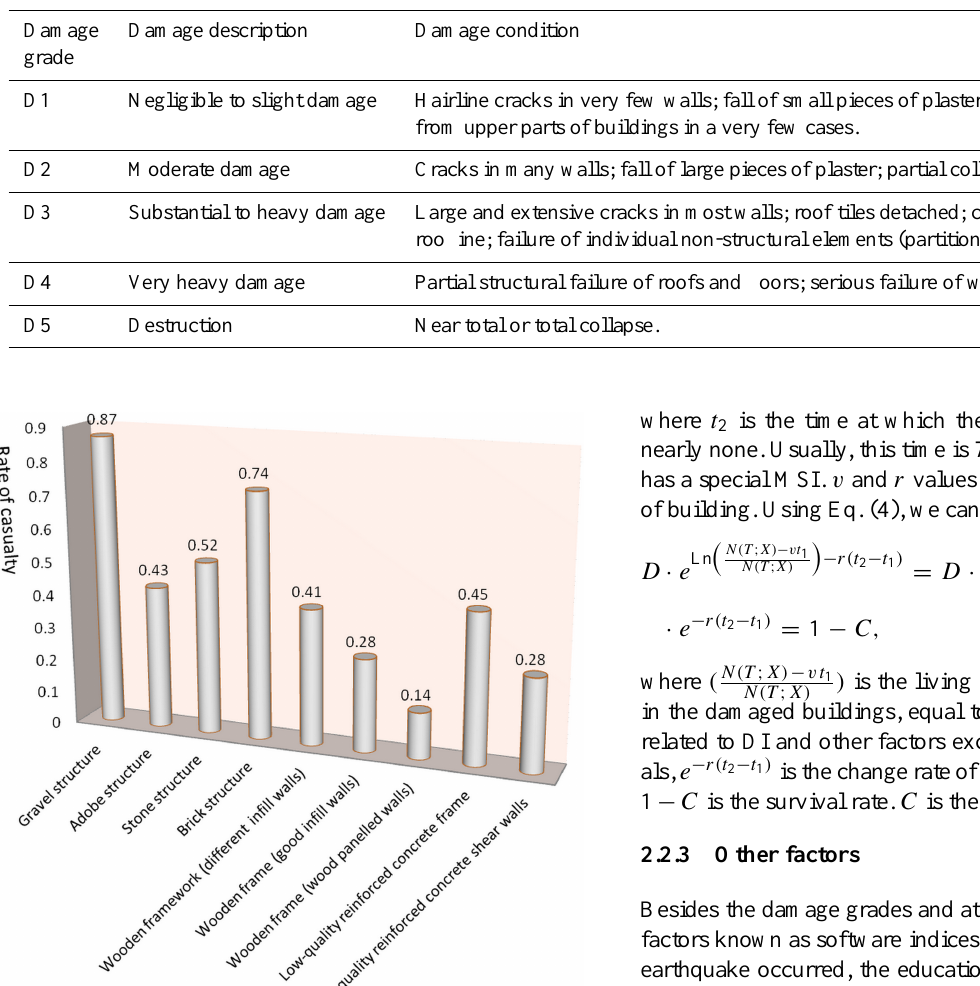
trapped people may be still alive in wooden-frame